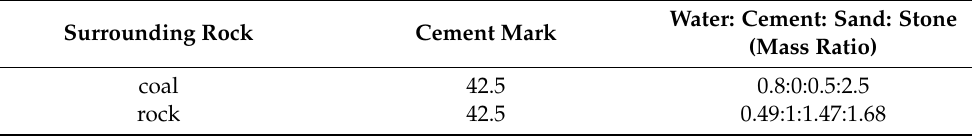
Table 2. Ratio design of surrounding rock on anchor specimen.